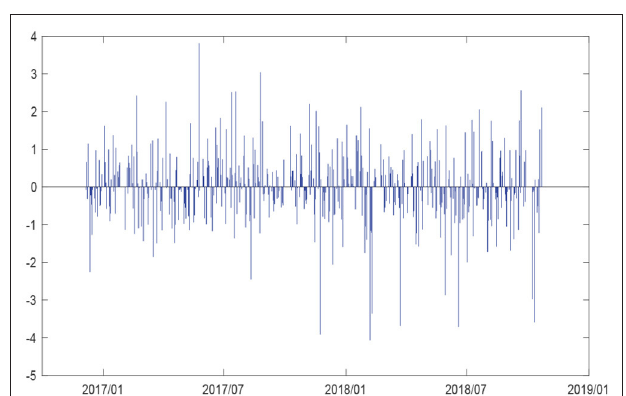
FIGURE 5 | Residual sequence of carbon